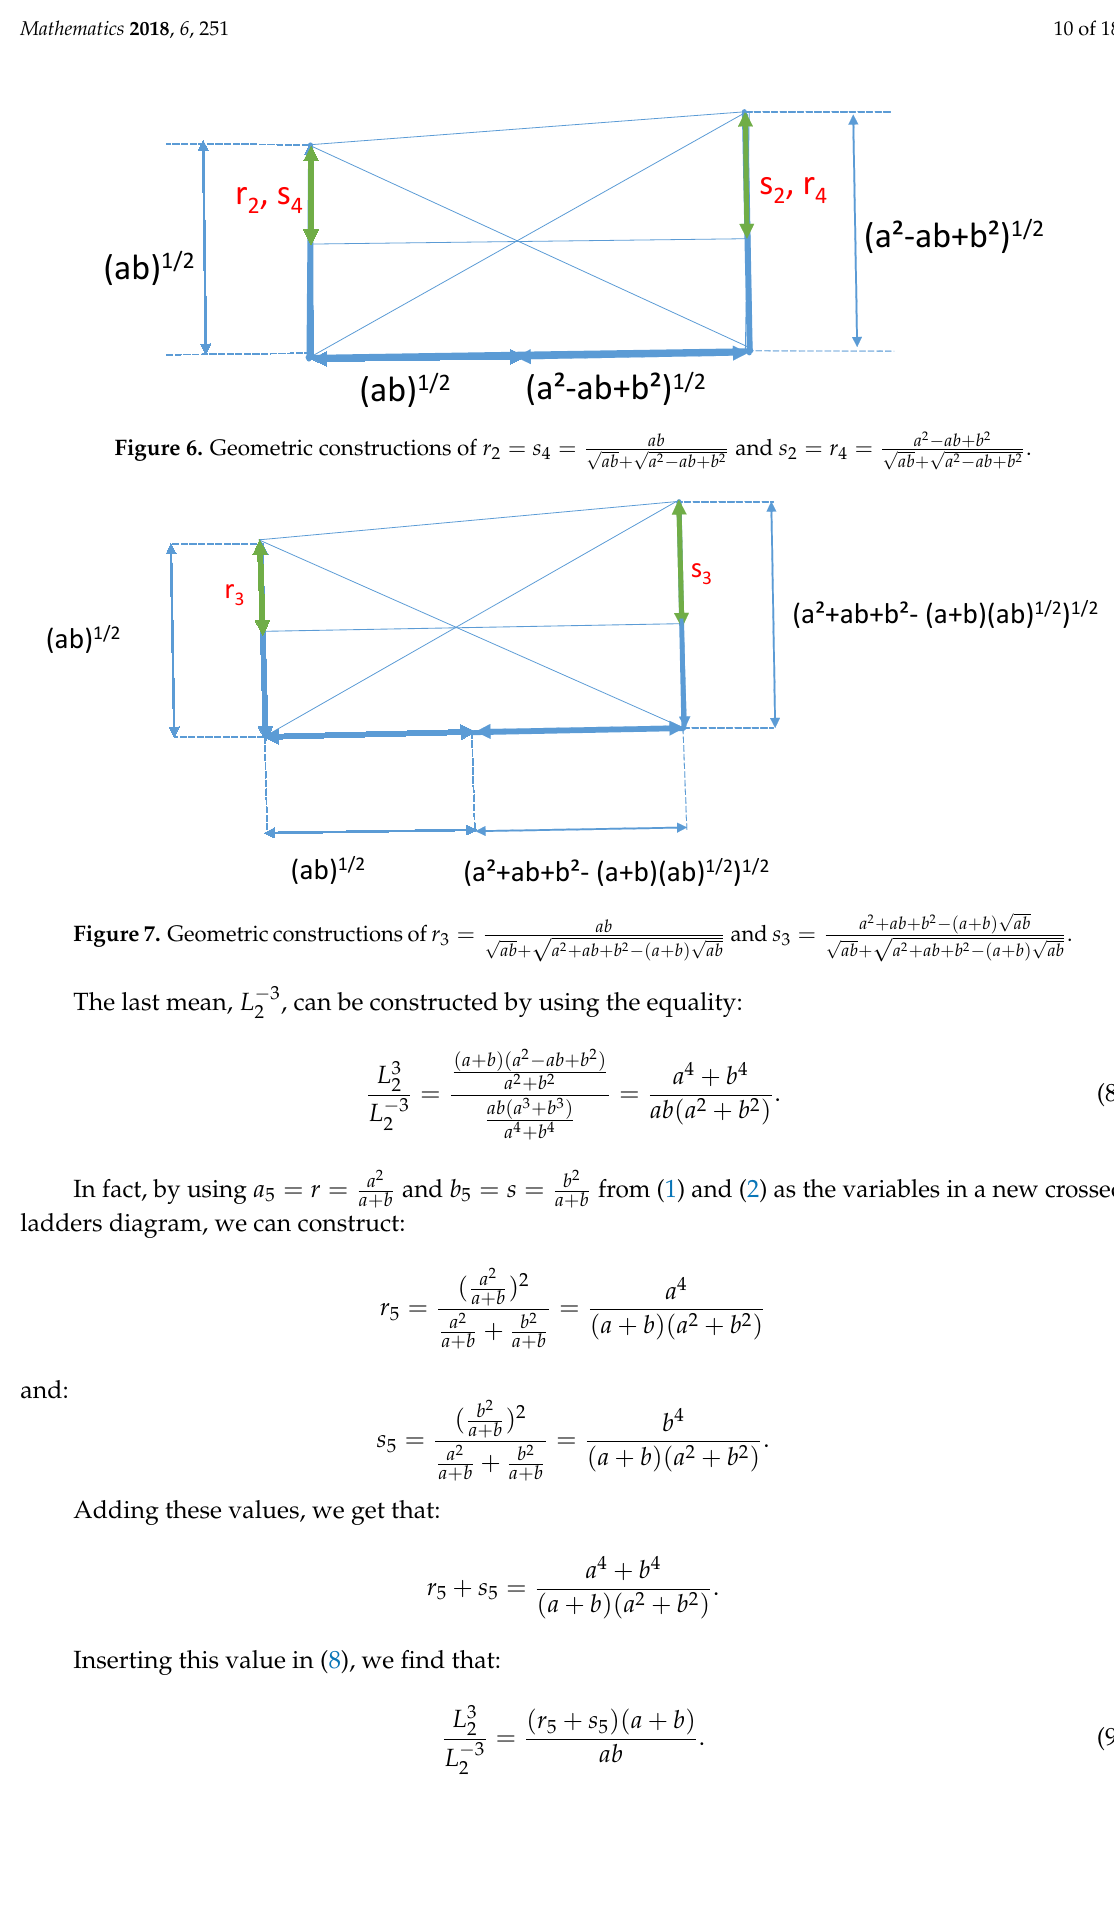
Figure 5: Geometric constructions of r